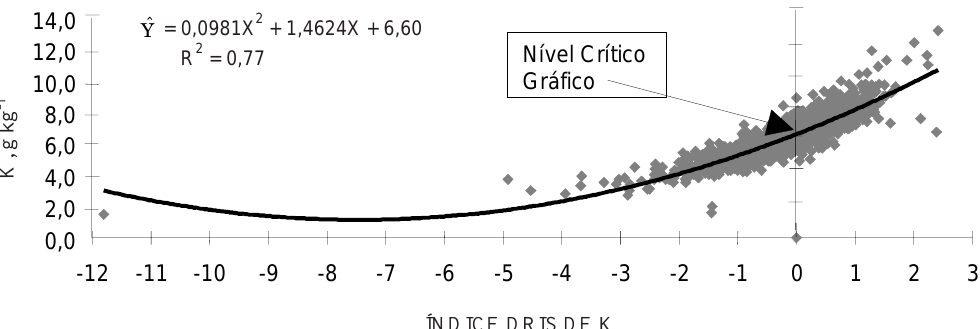
Figura 4. Gráfico de dispersão e regressão quadrática entre o teor de K em relação ao índice DRIS de K nas folhas de 1.213 árvores adultas de